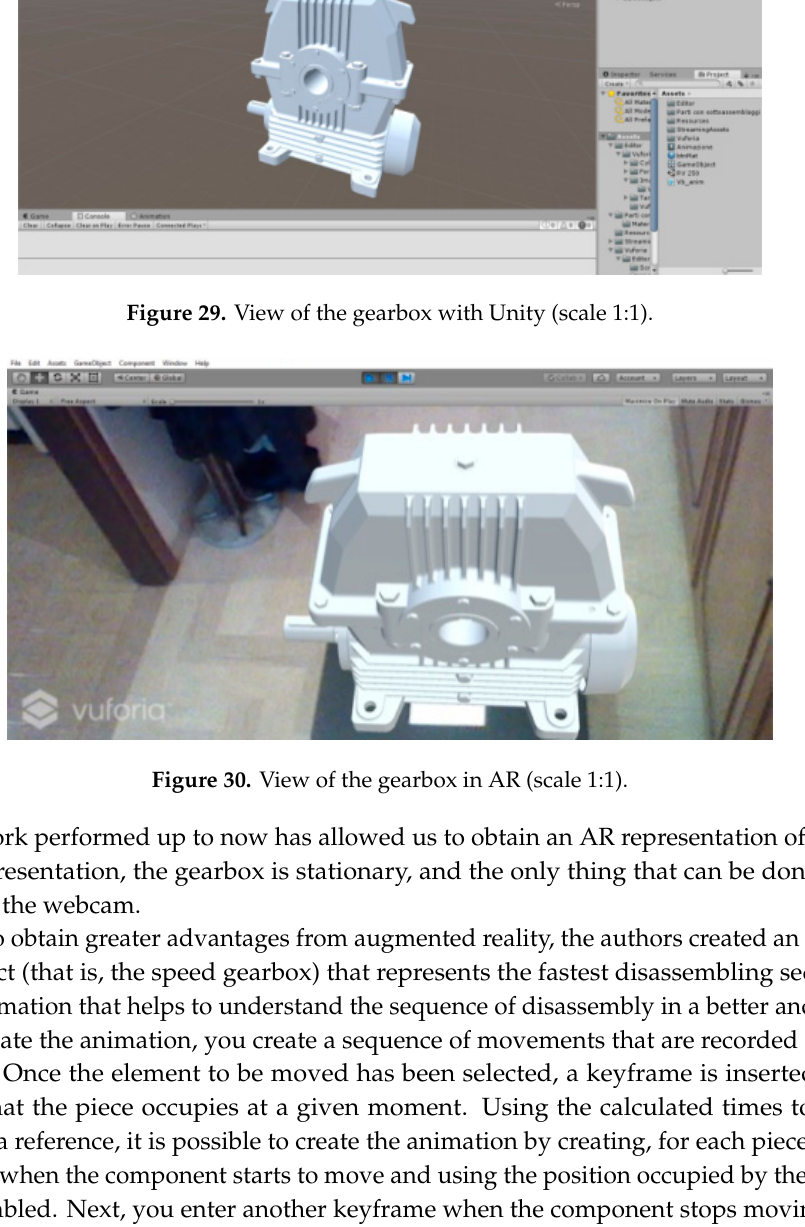
Figure 28. View of the AR tree (scale 1:1).